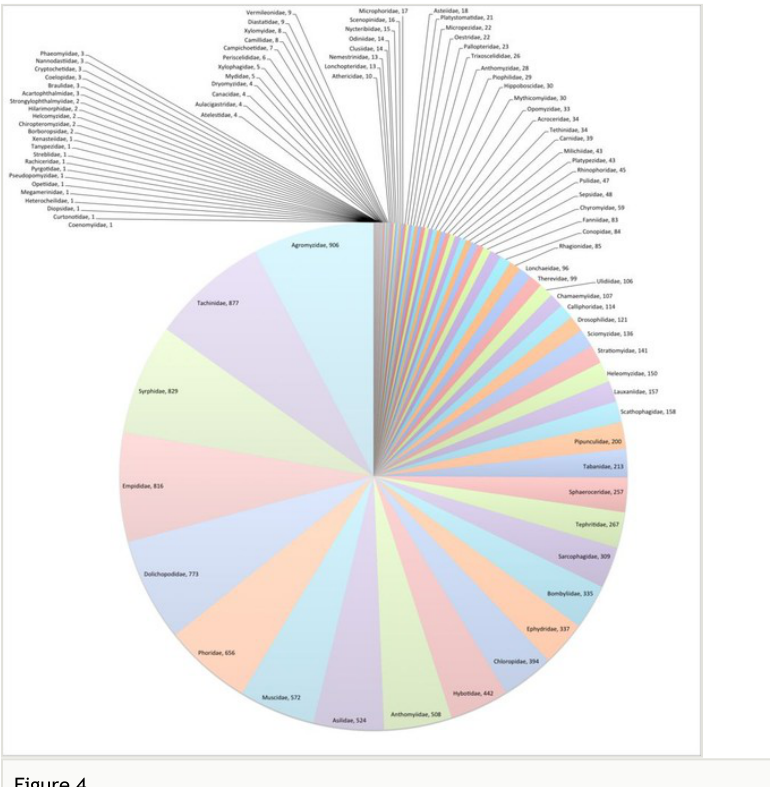
Fauna Europaea Diptera–Brachycera species per family. See Table 1 for family statistics. For full resolution see Suppl. material